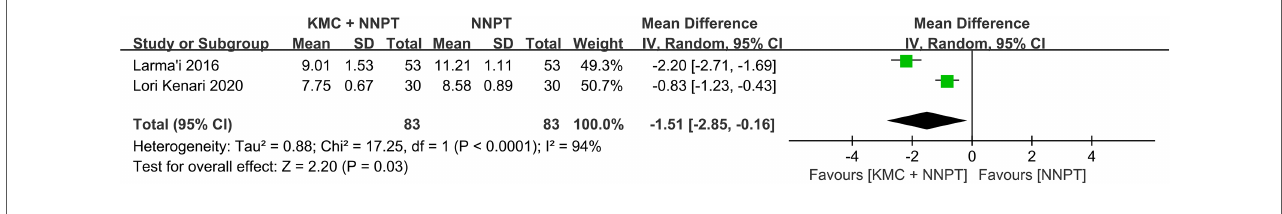
FIGURE 2 Forest plot comparing KMC+NNPT with NNPT alone on serum bilirubin at 72 h after intervention in neonates with non-pathological